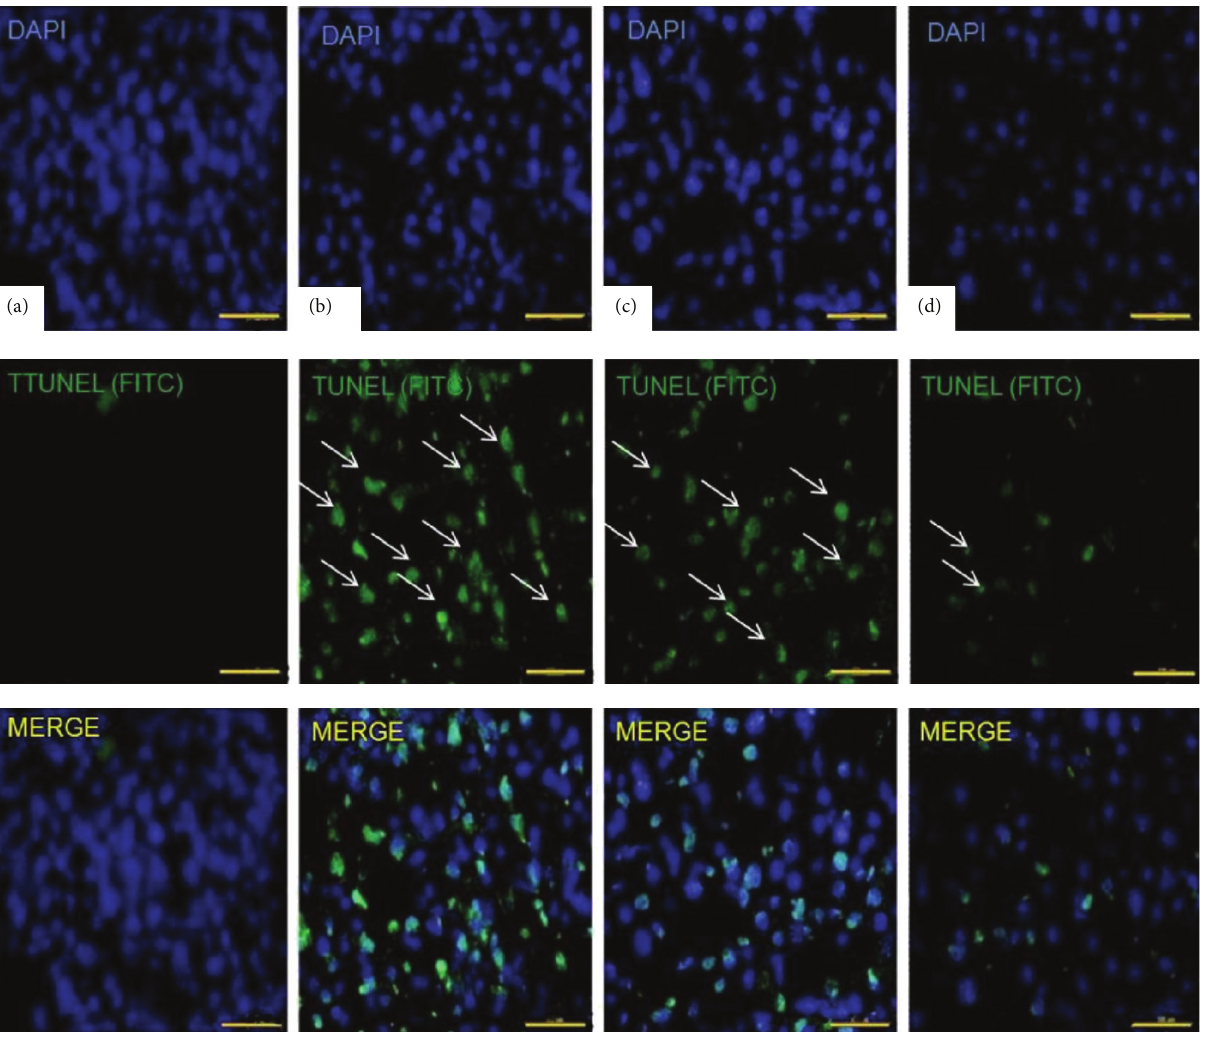
Figure 10: TUNEL apoptotic assay: assessment of apoptosis in experimental groups. (a–d) representing Groups I to IV: TUNEL-positive nuclei (green) in liver sections represent apoptotic cells. Nuclei were counterstained with DAPI (blue) (400x, scale bar ∼ 100 𝜇 m).